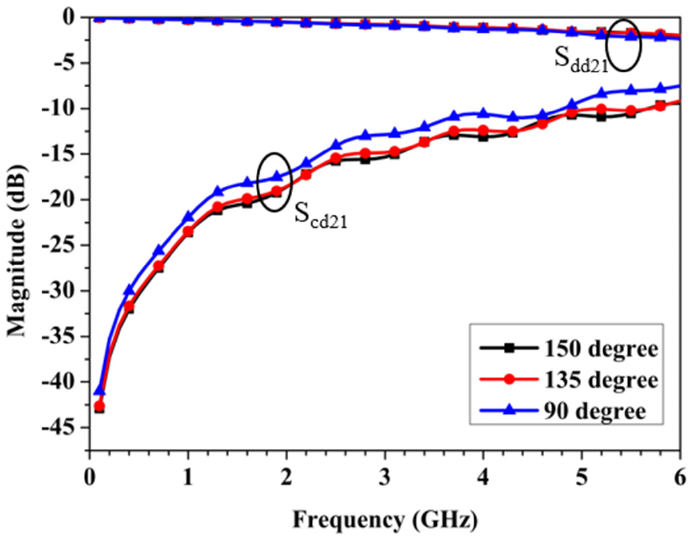
Figure 5. Simulated results of Sdd21 and Scd21 in structures with 90-, 135-, and 150-degree bends.